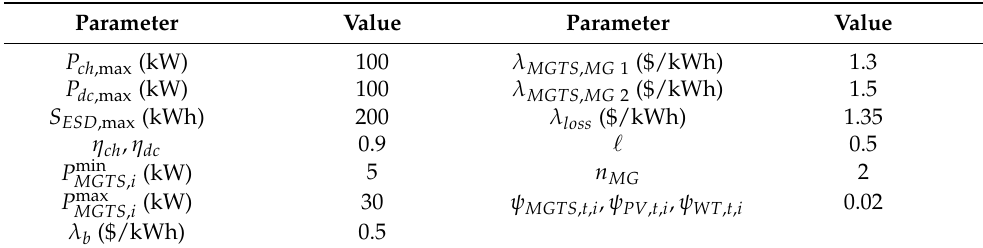
Figure 7. Transaction prices between MGs and grid as well as between MGs. Table 1. Main parameter se tt ings of each MG.